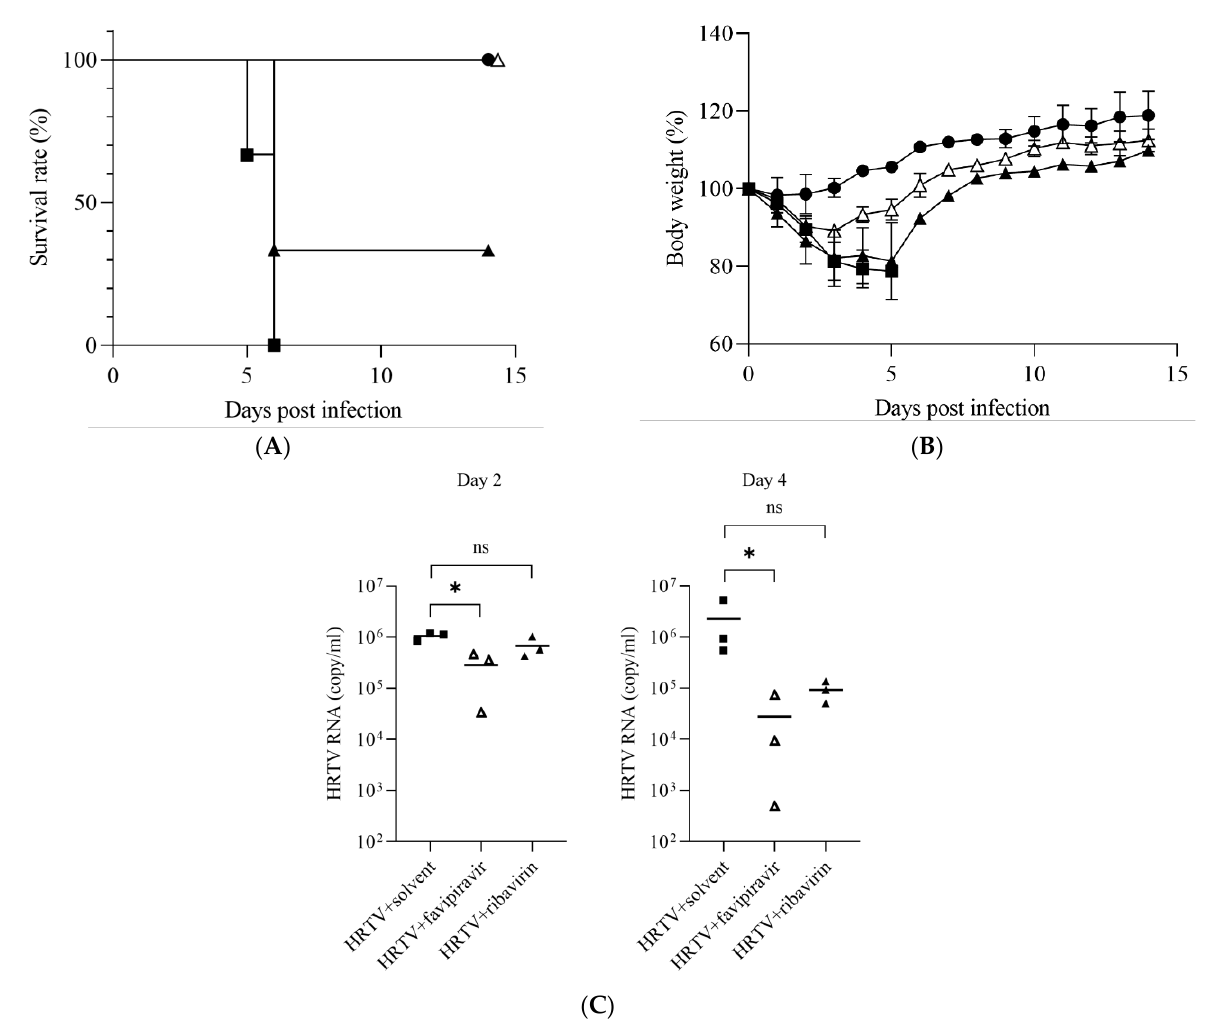
Figure 3. The in vivo efficacy of favipiravir and ribavirin in the treatment of IFNAR −/− mice infected with HRTV. IFNAR −/− mice were mock infected, indicated by the closed circles, or inoculated with 1 × 10 7 TCID 50 of HRTV intraperitoneally and treated with 60 mg/kg/day of favipiravir, 100 mg/kg/day of ribavirin, or the same amount of 0.5% methylcellulose, indicated by the open triangle, closed triangle, or closed square, respectively, from 0 to 4 days postinfection. ( A ) The survival rates of the mice ( n = 3). ( B ) Bodyweights of the IFNAR − / − mice. The relative bodyweights are shown as means with standard deviations ( n = 3). ( C ) The copy numbers of HRTV RNA in blood of the infected mice at 2 and 4 days postinfection. The levels of significance were determined in comparison with the results of the group of mice infected with HRTV and treated with solvent using a Kruskal–Wallis test. * p <